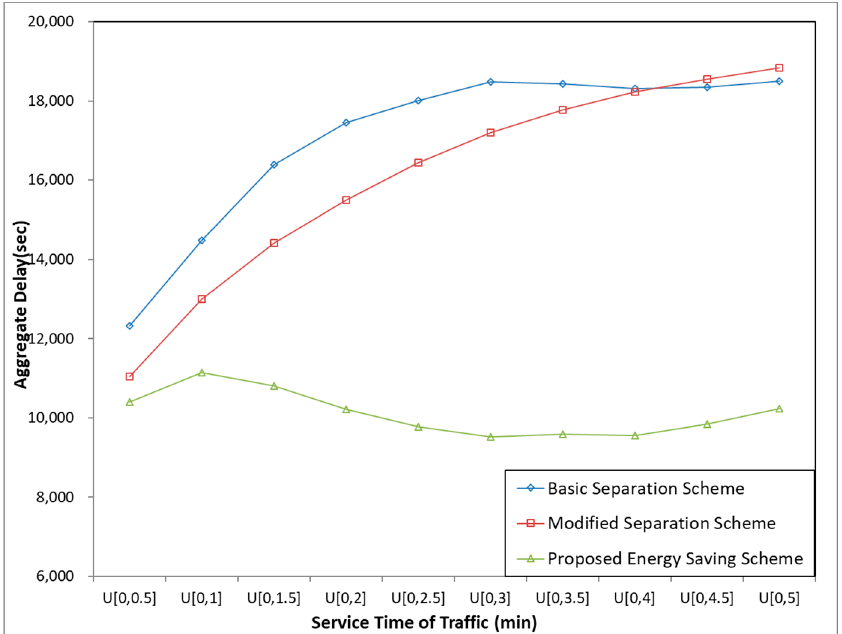
Figure 19. Total energy consumption of BSs.